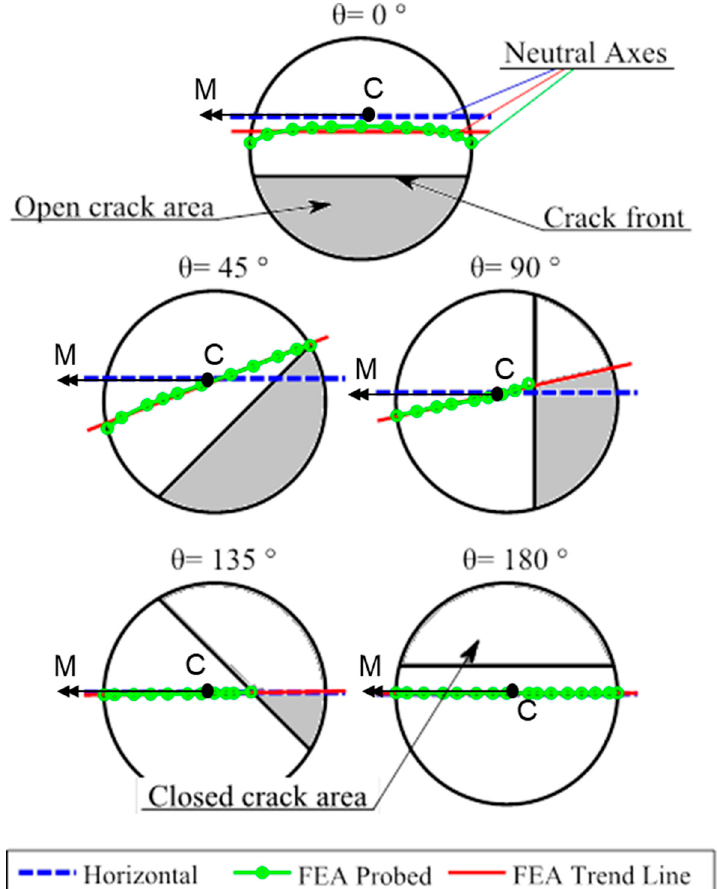
Figure 6. Predicted neutral axis orientations with the crack at various positions.